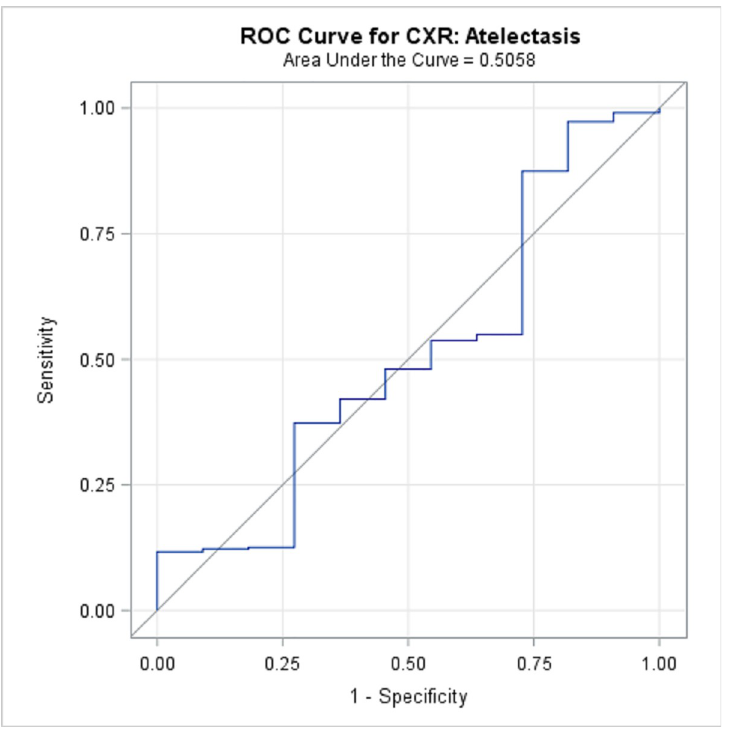
Fig 3. ROC Curve for CXR Atelectasis.